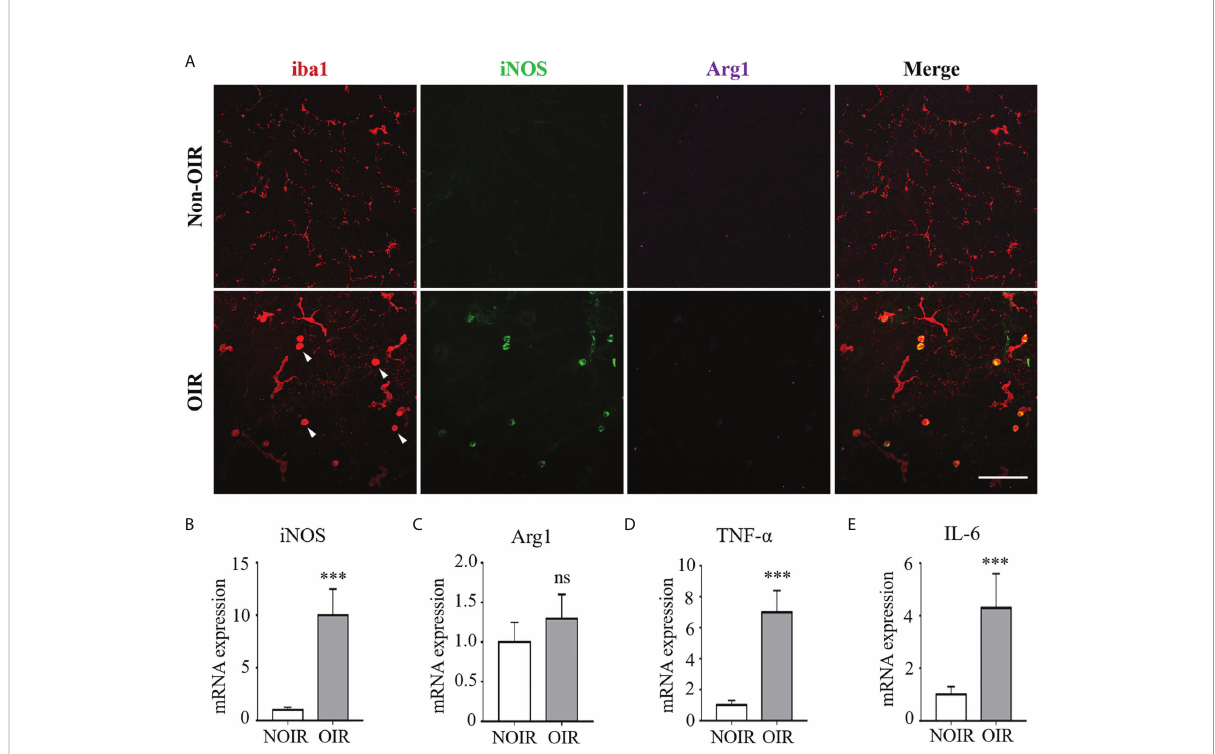
FIGURE 1 M1 microglia/macrophage polarization with increased in fl ammatory responses in retinal neovascularization. Microglia/macrophage polarization were evaluated on P17 in the OIR. (A) Representative images of immuno fl uorescence staining on retinal whole-mounts showed iba1 + microglia/ macrophages were activated and featured as large cell body with few branches in the OIR retina (arrow heads). The activated microglia/ macrophages presented distinct co-labeling of iNOS (M1 marker). Instead, there was few staining of Arg1 (M2 marker) in both OIR retina and non-OIR control. Scale bar, 100 m m. (B, C) Real-time PCR showed that mRNA level of iNOS (B) was increased while Arg1 (C) was insigni fi